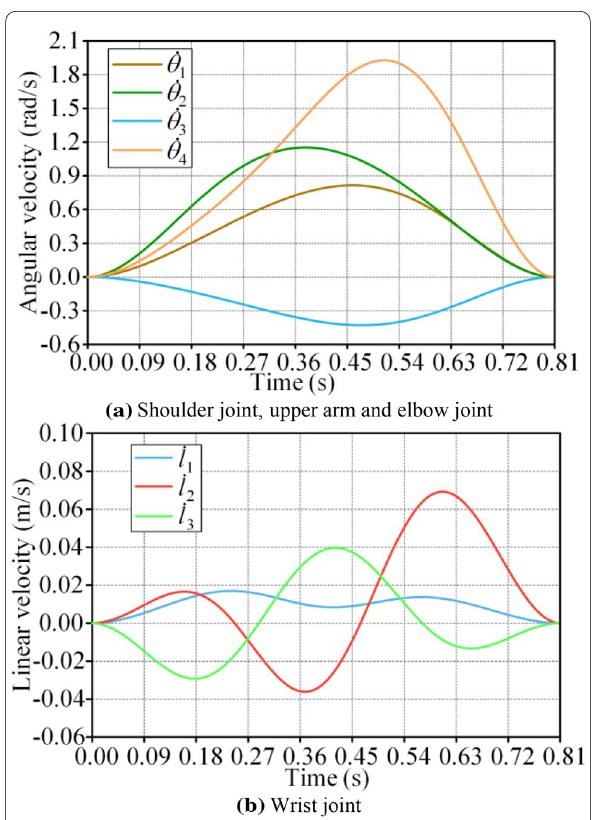
Figure 9 The acceleration profile of each joint using quintic B-splines